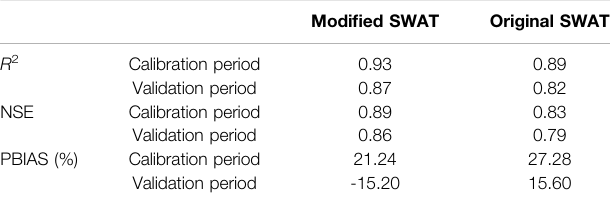
TABLE 2 | The performance of the original and modi fi ed Soil and Water Assessment Tool (SWAT) models in simulating the monthly stream fl ow. Modi fi ed SWAT Original